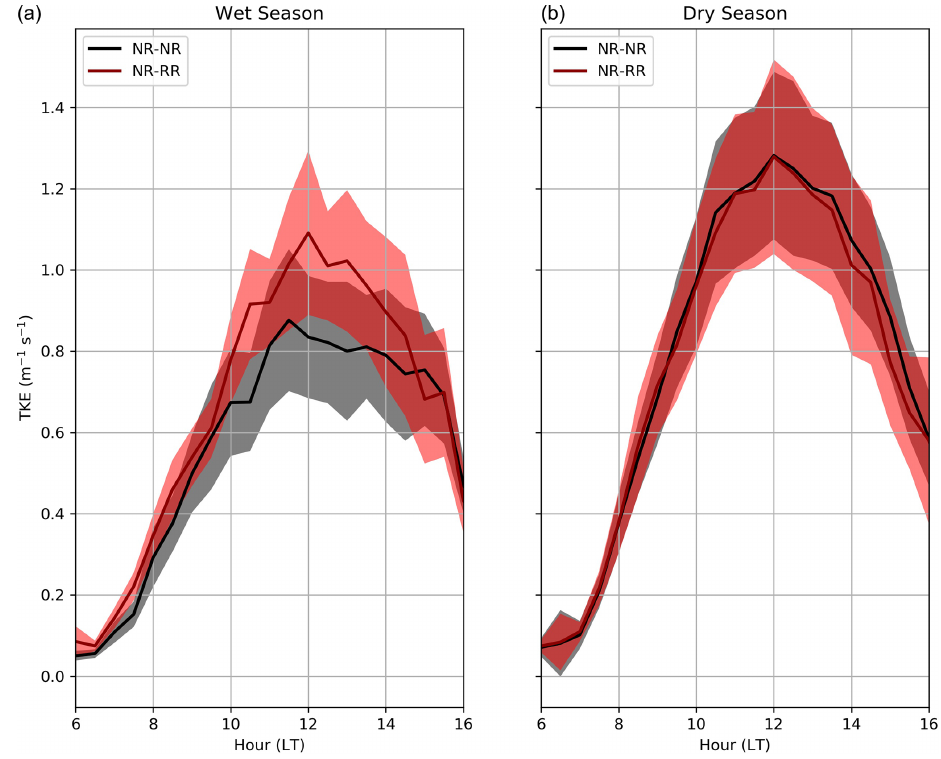
Figure 10. Mean (composite dataset) turbulent kinetic energy derived with ECOR for dry and wet seasons and NR–NR and NR–RR transi- tions. Shaded areas represent 1 standard